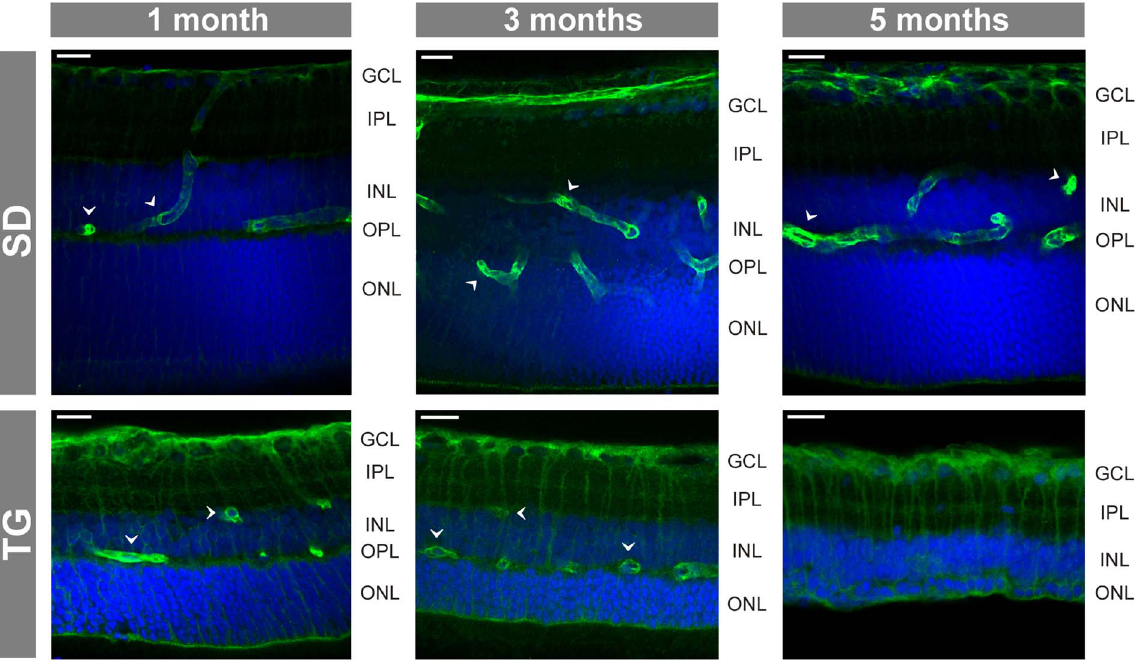
Figure 6. Age-dependent alterations in the immunolocalization of Kir4.1. Retinal slices obtained from control (SD; above ) and transgenic (TG) rats ( below ). Cell nuclei were labeled with Hoechst 33258 ( blue ). Arrowheads , perivascular labeling. GCL, ganglion cell layer; IPL, inner plexiform layer; INL, inner nuclear layer; ONL, outer nuclear layer; OPL, outer plexiform layer. Bars, 20 m m.